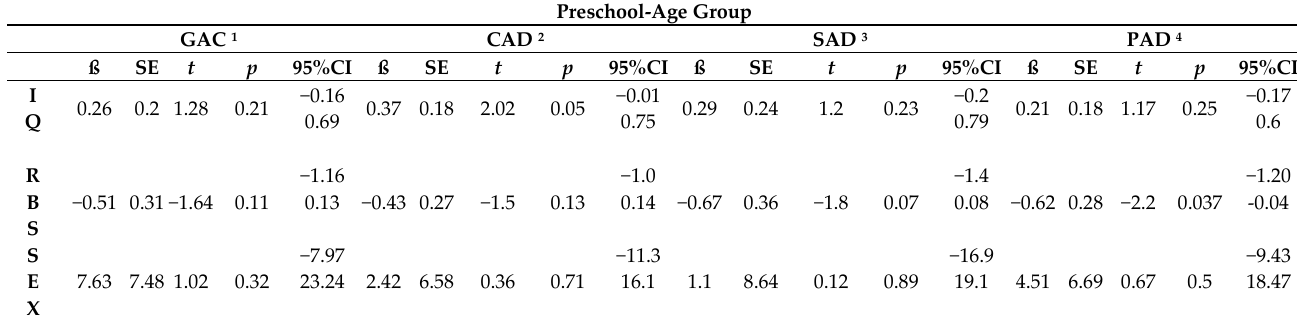
RBS-R = Repetitive Behavior Scale-Revised; SAD = social adaptive domain; SD = standard deviation. An alpha level of 0.05 was used for all statistical analyses. When performing multiple comparisons (up to 16), we adjusted the p -value using the Bonferroni correction. To keep the family-wise error rate at <0.05, the alpha level was set at 0.003 for each comparison. The results are reported as means ± SDs if not otherwise specified. All analyses were performed using the Statistical Package for Social Sciences (SPSS) software (Version 25, Children 2021 , 8 , x FOR PEER REVIEW Inc., Chicago, IL, USA). Table 3. Relationship between Adaptive Functioning and Repetitive Behaviors: multiple regression analysis.